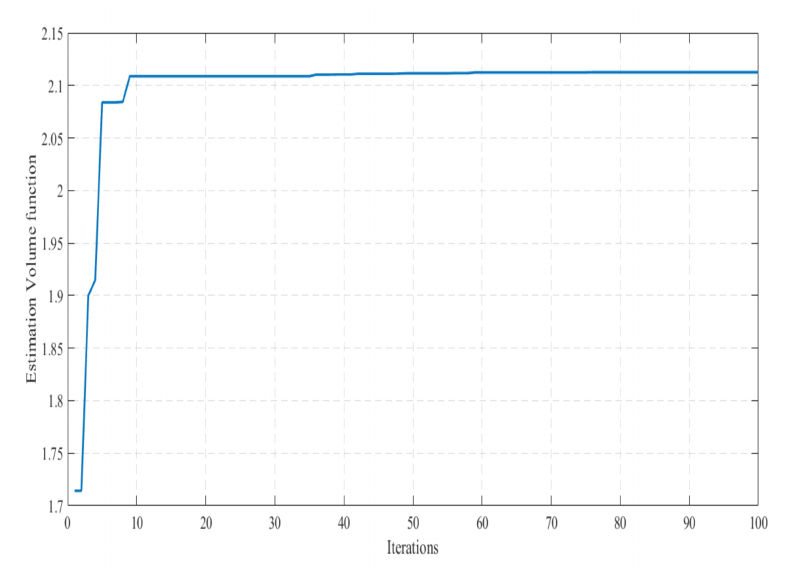
Figure 3. Evolution of Ω ( G ) using CPSO method for the Van der Pol example.